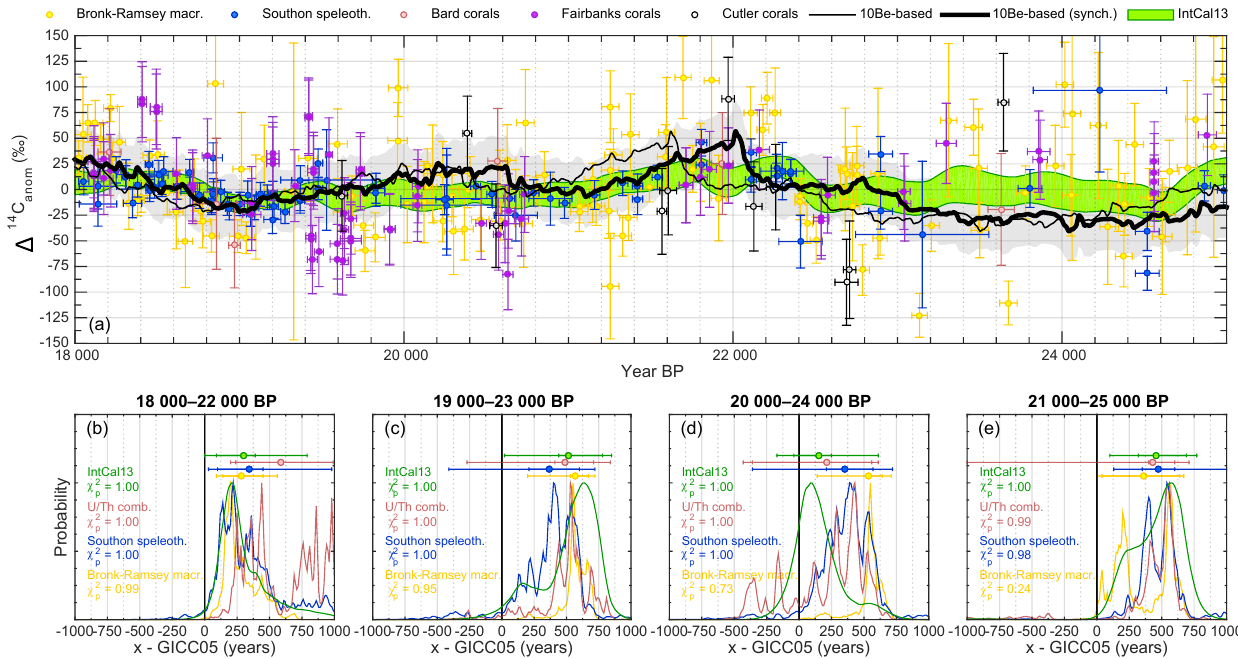
Figure 8. Synchronization results between 18000 and 25000 years BP. (a) The thin black line shows the modeled (cid:49) 14 C curve based on the ice-core stack on its original timescale. The bold black line and grey shading show the synchronized ice-core record including assumed ± 1 σ uncertainties of ± 30‰. The different colored symbols indicate various 14 C datasets underlying IntCal13, which is shown as the green envelope. Lower panels: each panel shows PDFs of the inferred timescale difference between the ice-core stack and IntCal13 (green), a combination of all U / Th-dated records (speleothems–corals, pink), the H82 speleothem (blue), and Lake Suigetsu (yellow). Symbols of similar color show the inferred mean and 68.2% and 95.4% confidence intervals. Color-coded text indicates χ 2 probabilities for the goodness of fit between modeled and measured (cid:49) 14 C curves after synchronization. Small (e.g., <0.1) values would indicate significant disagreement. Note that all χ 2 probabilities are relatively high, indicating that our uncertainty estimate for the modeled (cid:49) 14 C is very conservative. Each of the lower panels refers to a specific subsection of the data indicated at the top of each